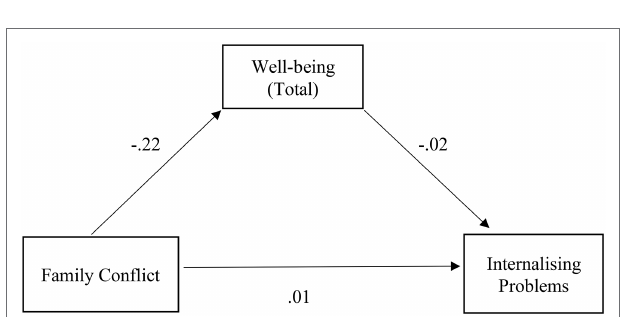
FIGURE 5 | Illustration of the direct effects of the family conflict for internalizing problems through the mediator well-being in clinical group. The represented coefficients are standardized. Total effect ( β = 0.01, p > 0.05).